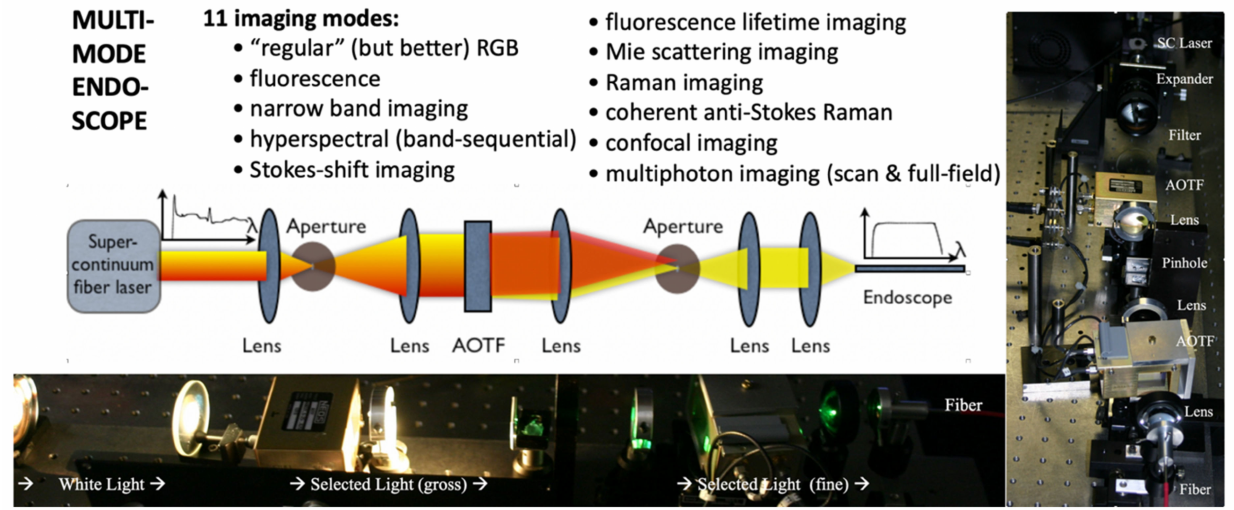
Figure 25. Multimode imaging system for minimally invasive surgery (see text for